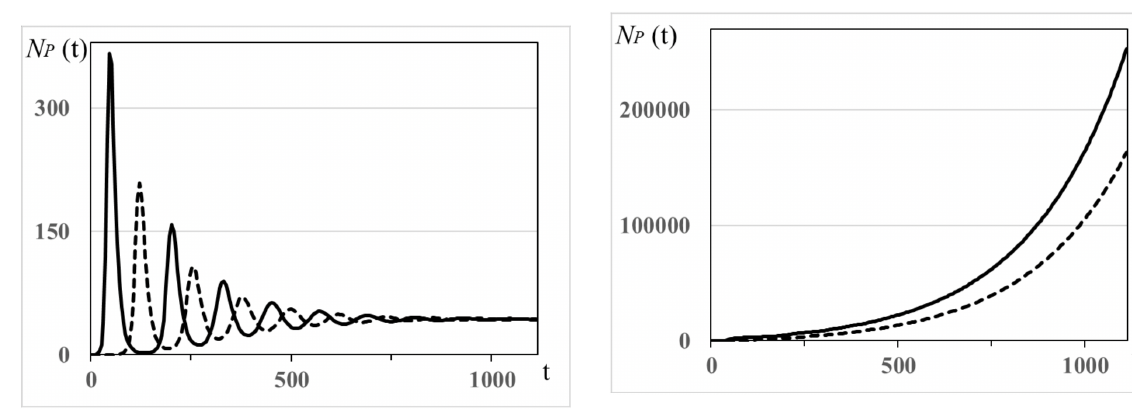
Fig. 11. Graphs of N P ( t ) for unstable dynamics for 2 different initial values ϕ ( a ) .